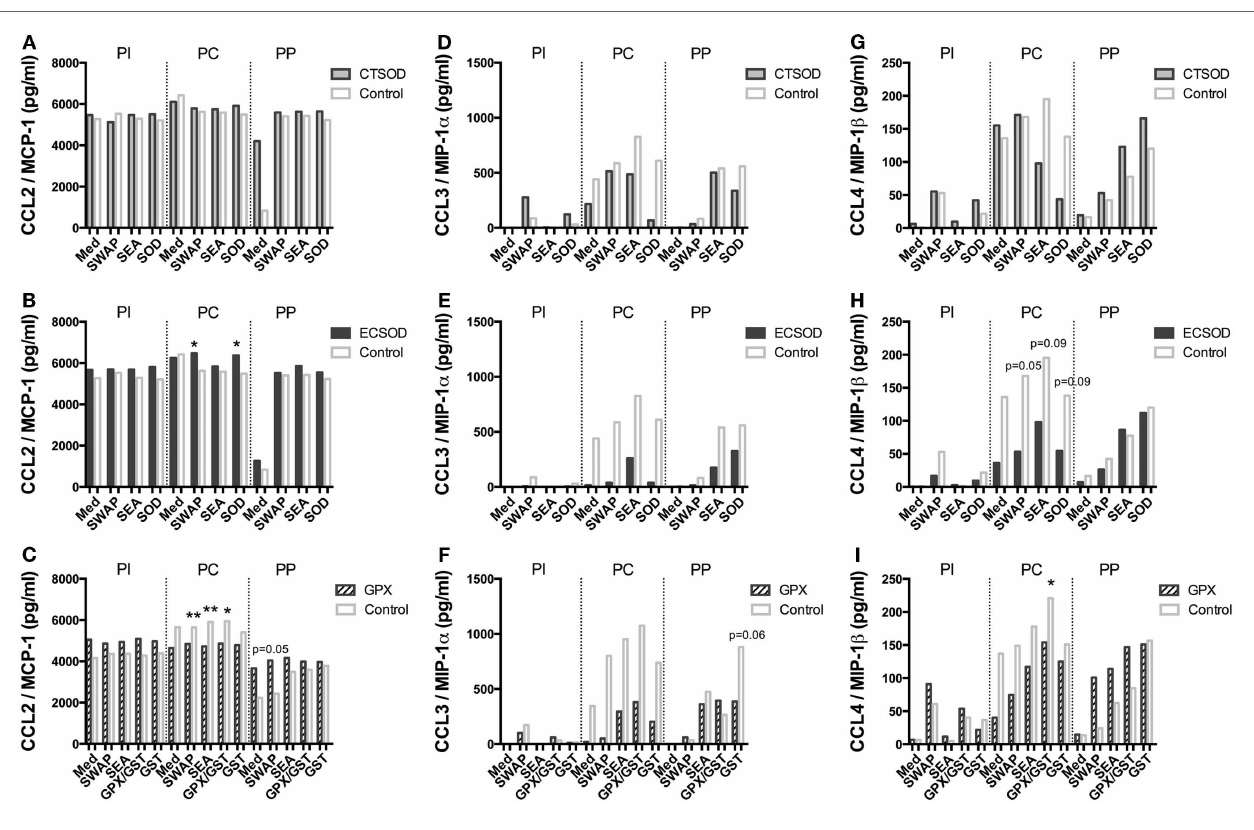
perfusion (PP). Values were expressed as median of cytokine secretion in five individual supernatants in relation to the Control baboons. Non-parametric (Kruskal–Wallis, Mann–Whitney) tests were applied. Values were considered statistically significant when p < 0.05, and assigned * p = 0.01–0.05; ** p = 0.001–0.01; and *** p = <